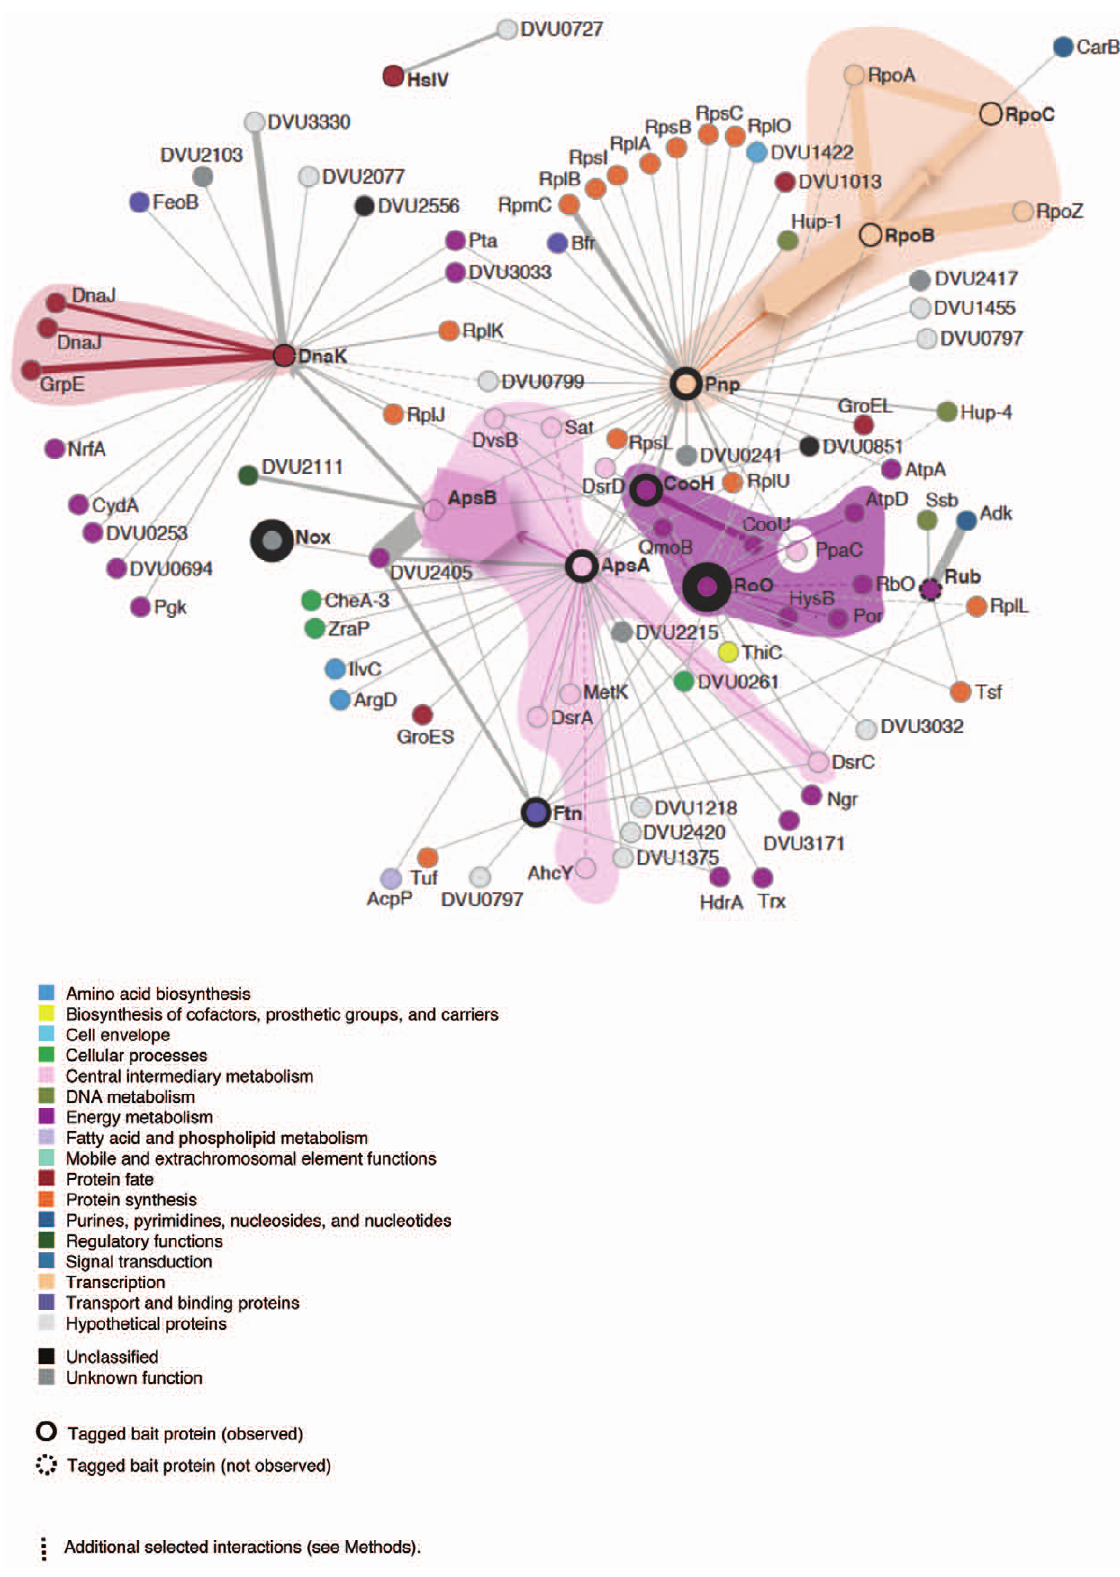
Figure 2. Partial D. vulgaris Hildenborough (JW801) high confidence protein-protein interaction network. Shown are the high confidence bait-prey protein interaction pairs from this study. Edges connecting nodes indicate a detected high confidence interaction between a bait and a pulled down prey protein. Nodes in the network are colored by TIGR functional role, as are edges where both nodes belong to the same TIGR role. Bait protein nodes are surrounded by a thicker black circle proportional to the normalized adjusted median-max emPAI value for the bait